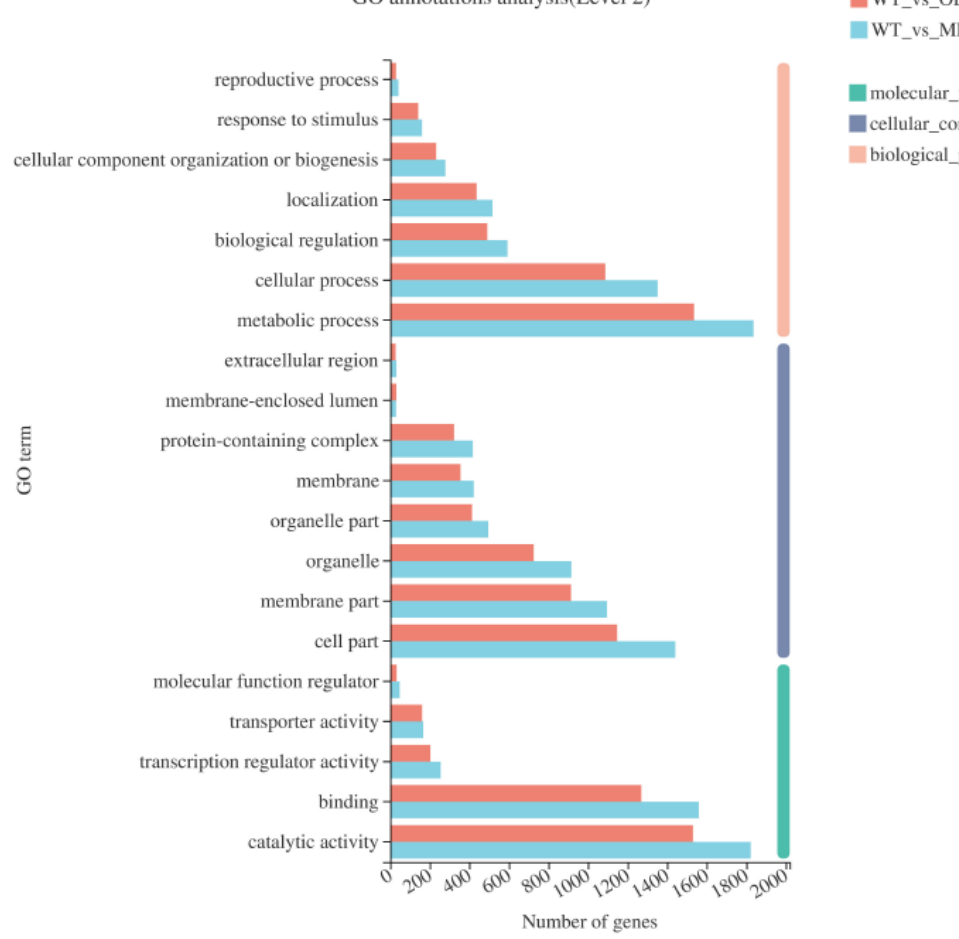
Figure 2. GO function analysis of DEGs. WT_vs_OL_G represents DEGs between Olae1 and T23 wild-type strain, WT_vs_ML_G represents DEGs between Mlae1 and T23 wild-type strain. GO enrichment analysis was performed based on DEGs between Mlae1 and T23 (Figure 3). GO terms significantly enriched in the Mlae1 included the ncRNA metabolic process, rRNA metabolic process, organic cyclic compound biosynthetic process, and aromatic compound biosynthetic process. Downregulation of these genes may indicate a deficiency of Mlae1 in the previously mentioned terms. Further, KEGG enrichment analysis was performed to explore metabolic pathways regulated by the DEGs. DEGs between Mlae1 and T23 were mainly implicated in regulating ribosome biogenesis in eukaryotes, glycolysis/gluconeogenesis, the TCA cycle, and sphingolipid metabolism (Figure 4). Moreover, DEGs identified between Olae1 and T23 were involved in the TCA cycle, propanoate metabolism, oxidative phosphorylation, glycolysis/gluconeogenesis, and glycerophospholipid metabolism.